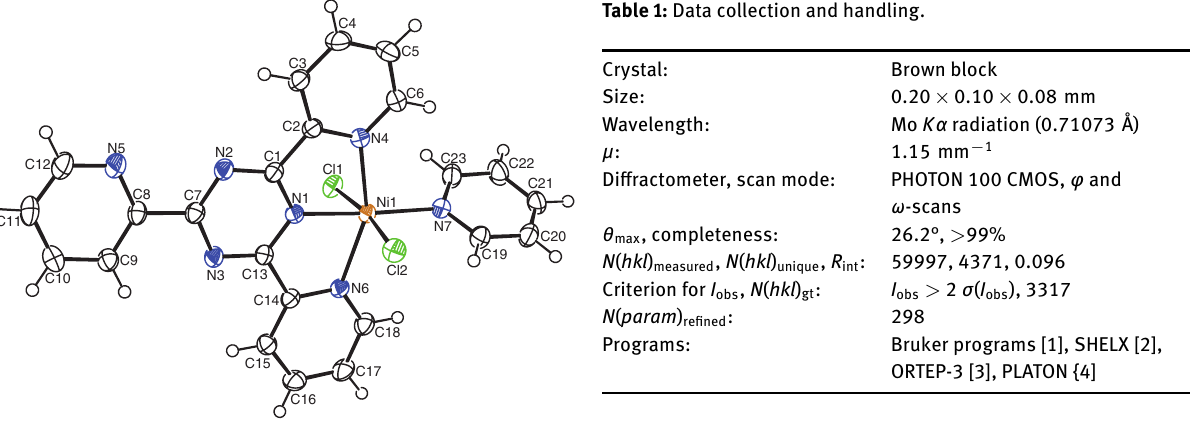
Table 1: Data collection and